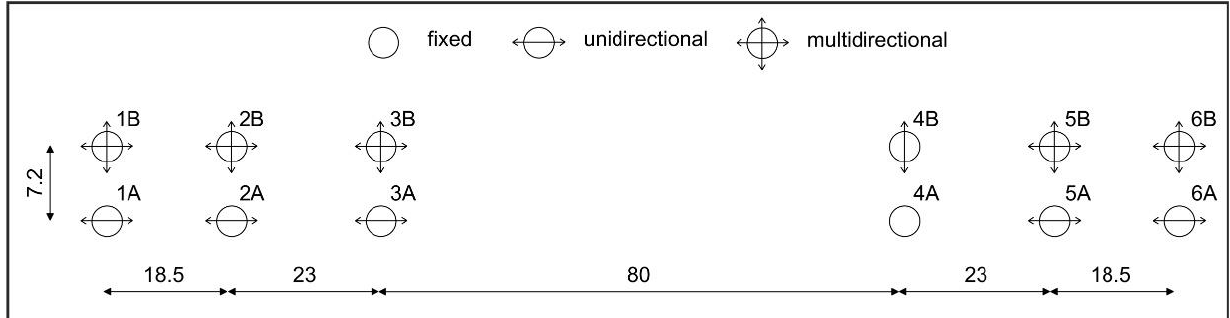
Figure 6. Bridge bearing specification and location (m).